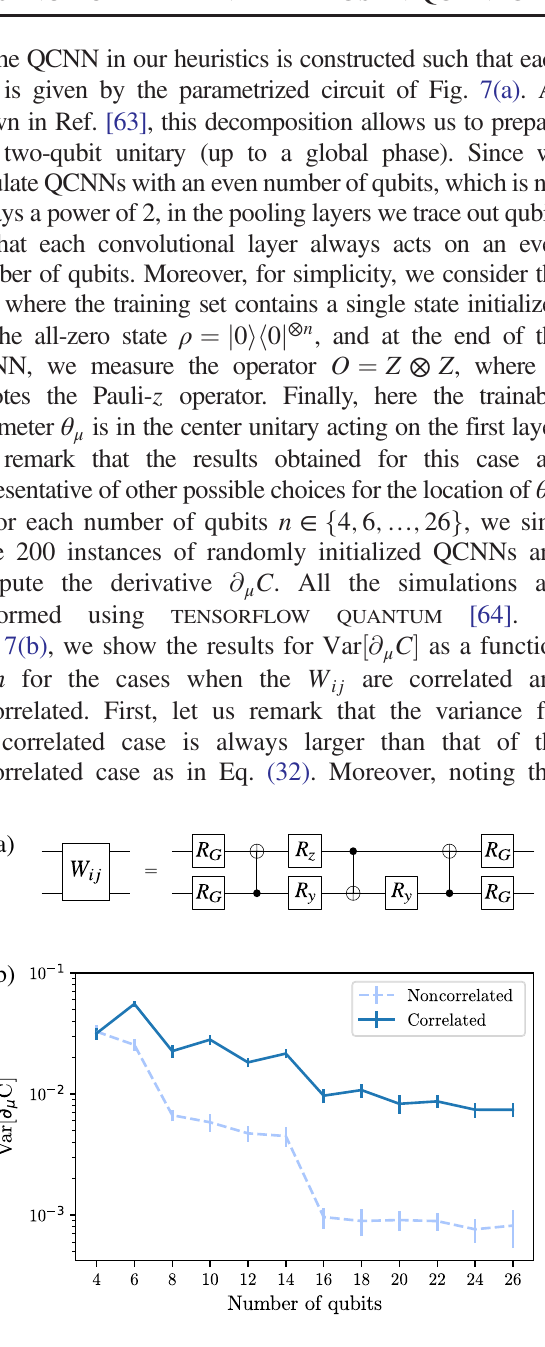
FIG. 7. Ansatz and results for the numerical simulations of the QCNN. (a) Ansatz for the two-qubit unitary W . Here R ij G ¼ e − iZ θ 1 = 2 e − iY θ 2 = 2 e − iZ θ 3 = 2 is a general single-qubit rotation para- metrized by three angles, and X , Y are Pauli operators. In addition, R and R denote single-qubit rotations about the y y z and z axes, respectively. (b) Heuristical scaling of the variance of the cost function partial derivative Var ½ ∂ μ C (cid:2) . The y axis is in a log scale. The solid (dashed) curve represents results for correlated (uncorrelated) unitaries in the convolutional layers. Error bars represent the standard deviation over 16 repetitions. Here we can see that Var ½ ∂ μ C (cid:2) is always larger when the unitaries are correlated. As n increases, we see that the curves are sublinear, indicating a subexponential scaling for Var ½ ∂ μ C (cid:2)